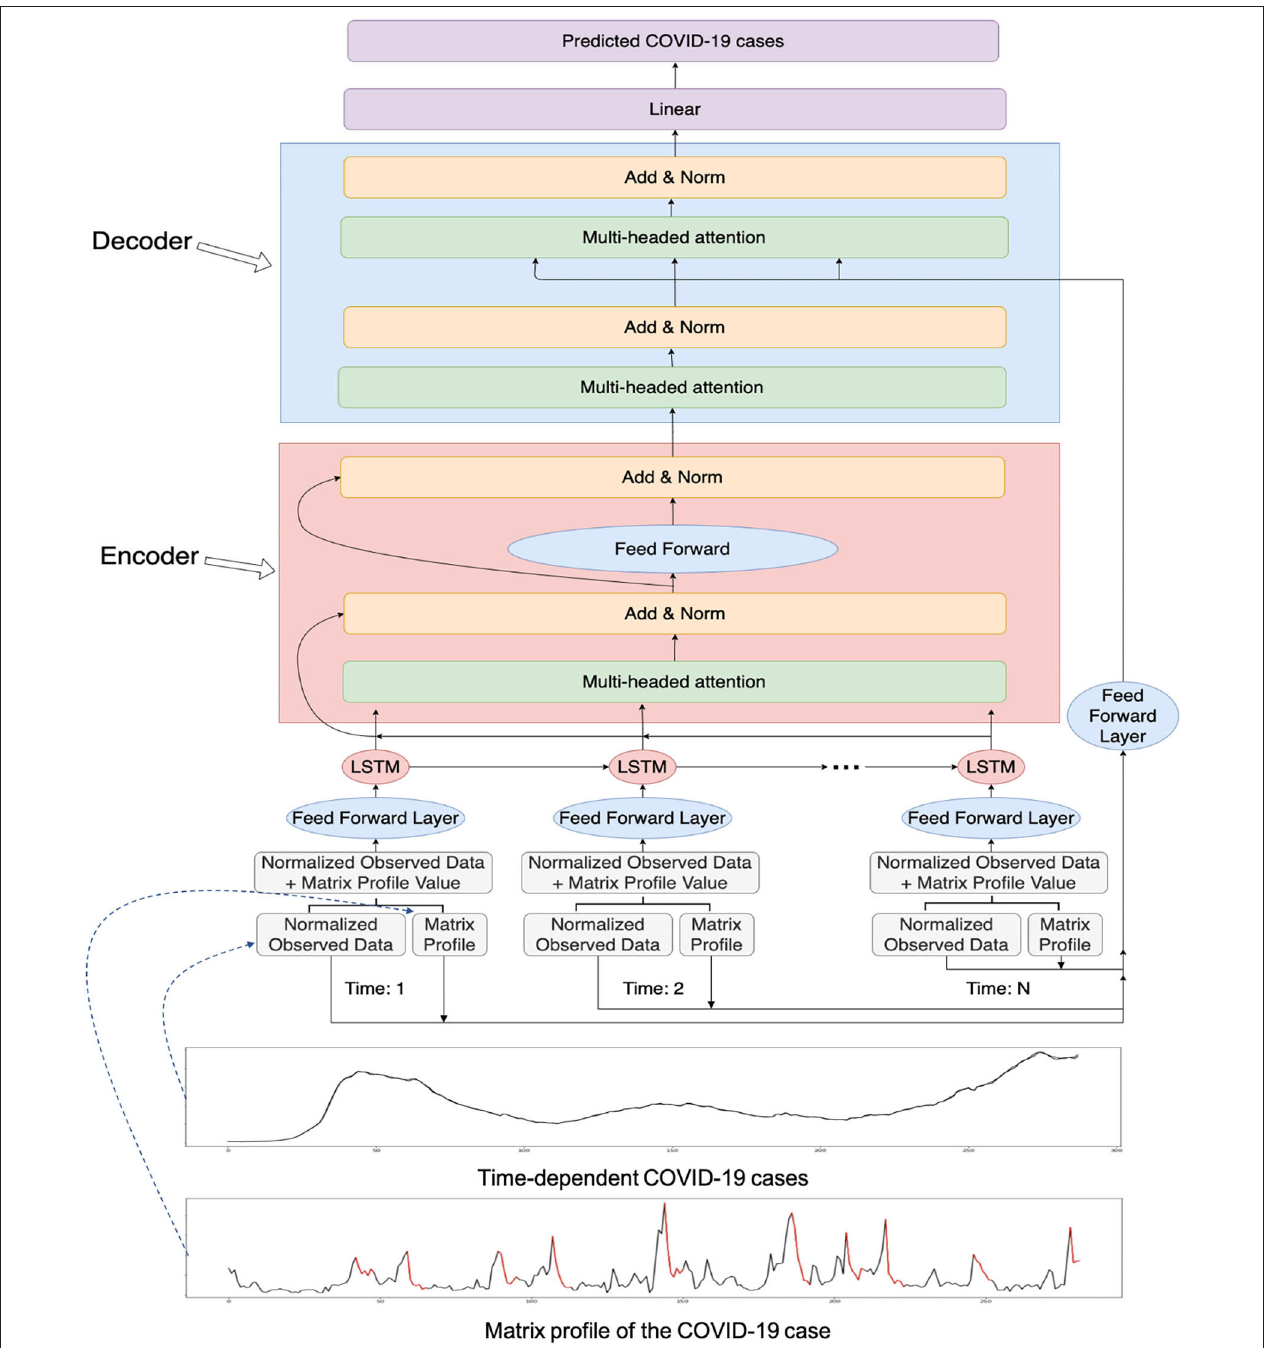
FIGURE 1 | The overall workflow of the proposed novel matrix profile-guided attention LSTM algorithm. Matrix profile feature could be the distance profile (the LSTM-MatAtt model) or the relative position profile (the LSTM-RelAtt). The matrix profile feature concatenated with the normalized observed data of the COVID-19 indicators are first input into the LSTM unit, then passed to the later steps of the encoder-decoder attention process. The final output is the predicted future values of the COVID-19 indicators.